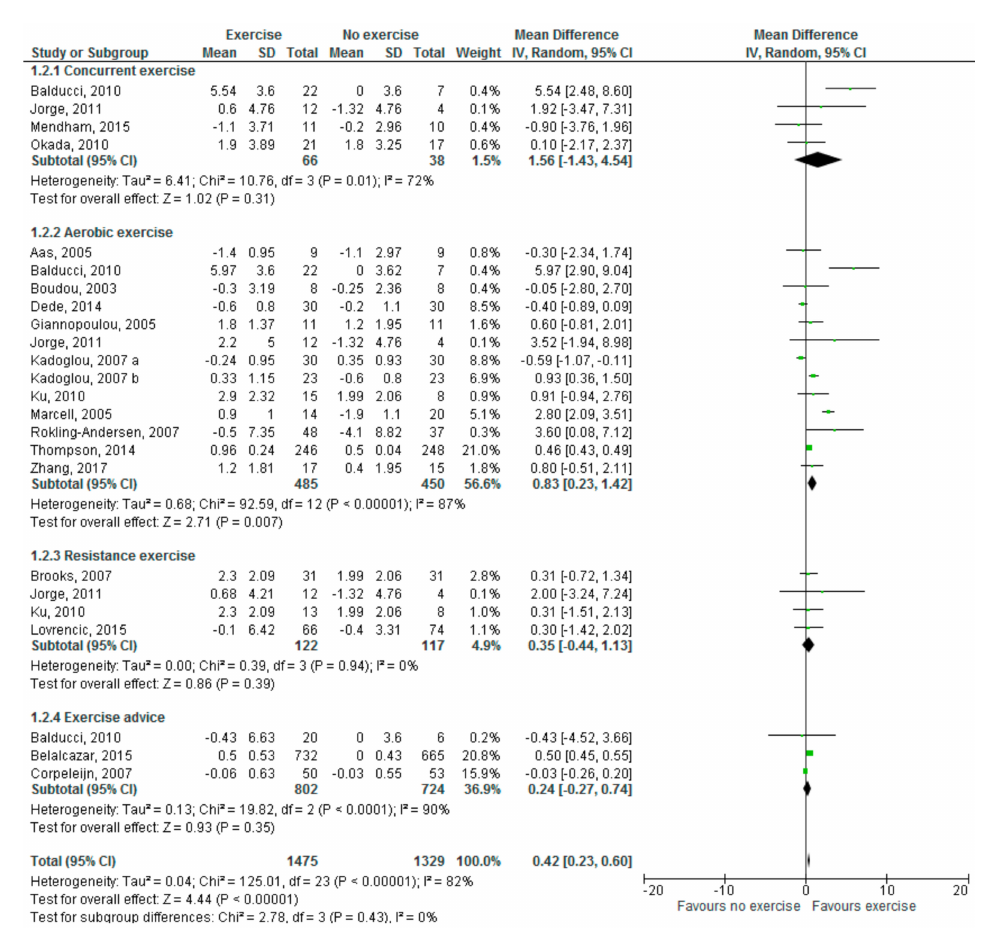
Figure 1. Effects of physical exercise, including different modalities, on adiponectin levels ( µ g/mL). Forest plot shows pooled mean differences with 95% confidence intervals (CI) for 24 effect sizes pooled from 19 trials (two separate effect sizes were pooled for different exercise modalities from Jorge [40] and Ku [51], and three from Balducci [39]). The green colored square represents the point estimate of the effect of the intervention for each trial. The horizontal line joins the upper and lower limits of the 95% CI of the effects. The square area represents the relative weight of the trial in the meta-analysis. The black colored diamond at the bottom represents the pooled mean difference with 95% CI for all study